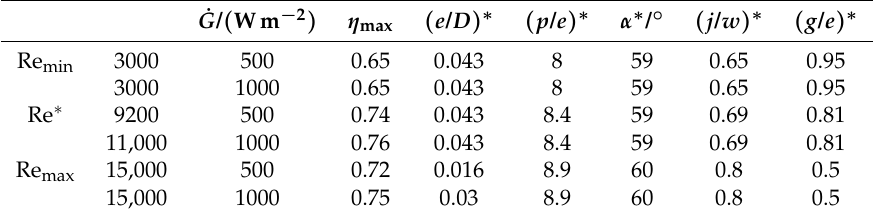
Table 2. Maximum efficiency and optimum roughness parameters according to the model developed by Singh et al.